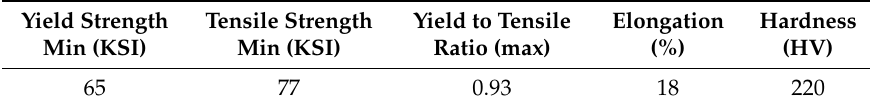
Table 3. Mechanical properties of X65 pipeline steel.